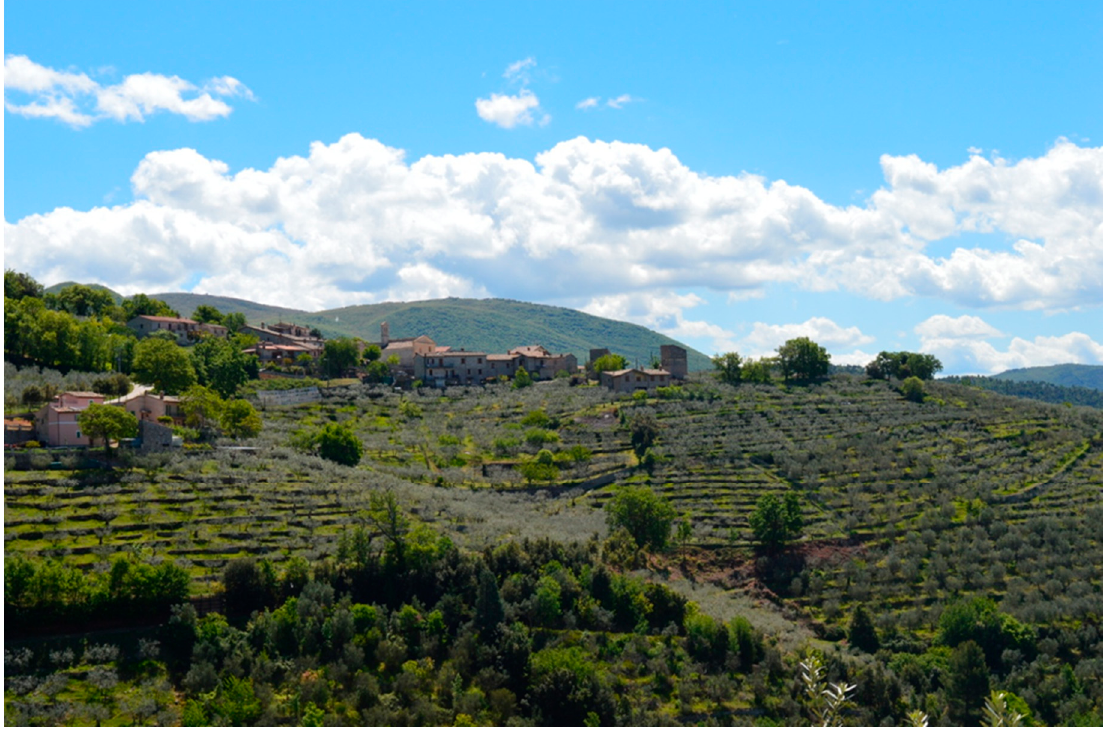
Figure 2. Olive trees band and down-hills Assisi-Spoleto with dry stone walls, in the territory of Campello sul Clitunno. Michela